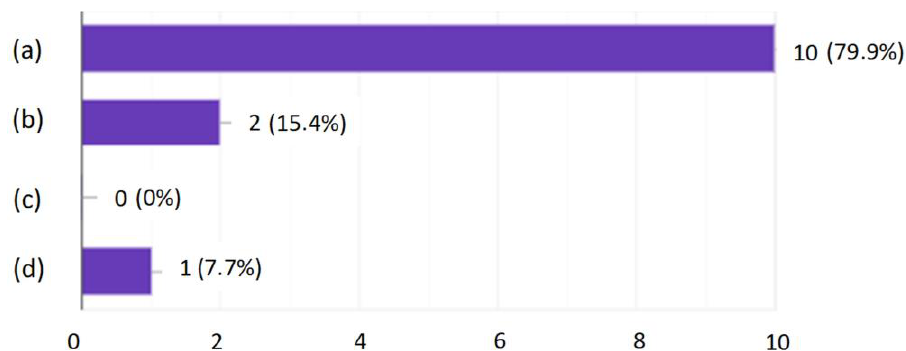
Figure 10. What do you think about the number of questions: ( a ) There were too many of them for one day; ( b ) The number of questions was just right; ( c ) There were not enough of them for one day.